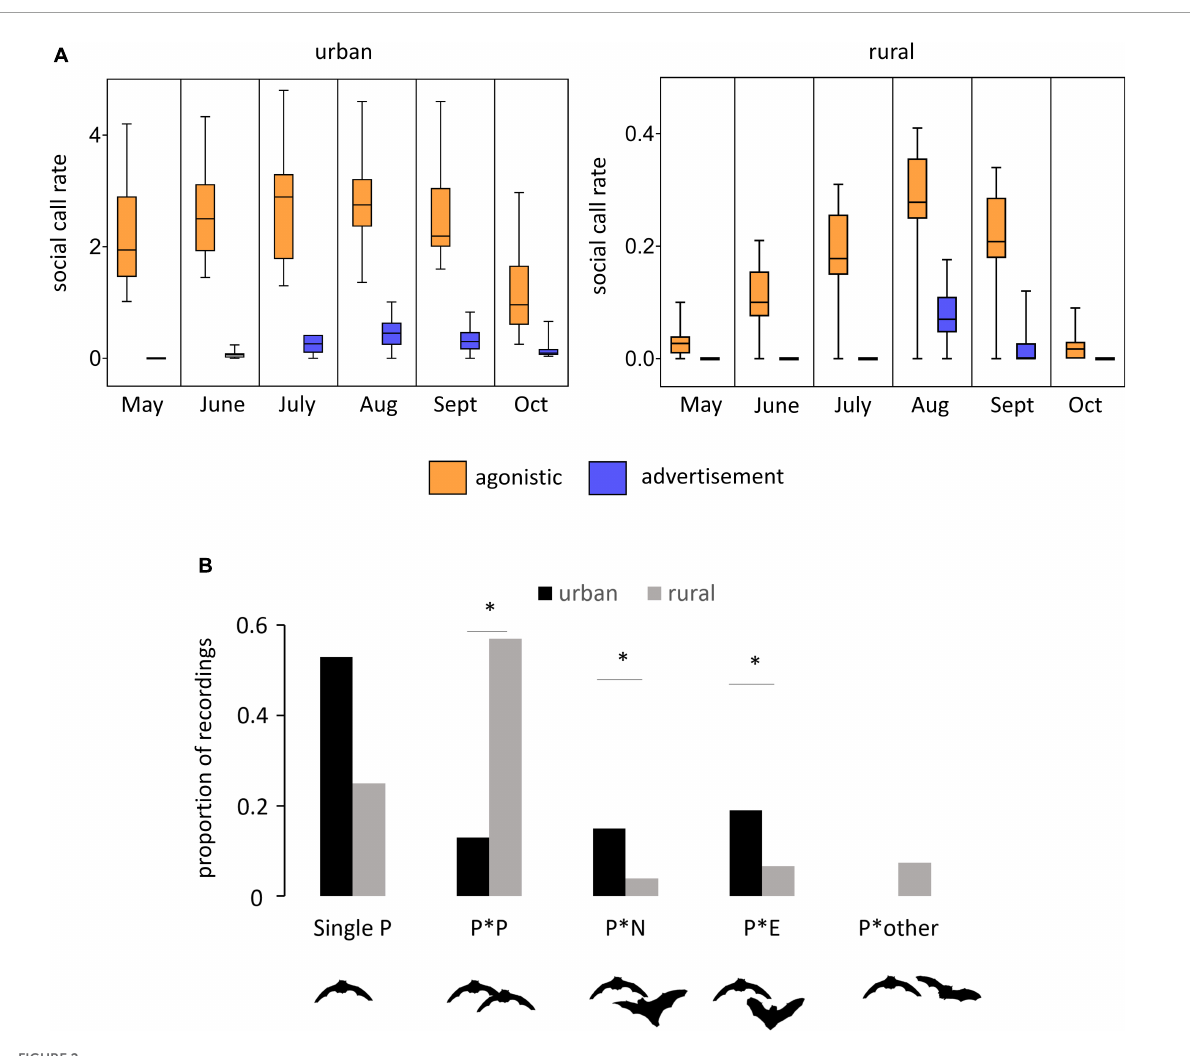
FIGURE2 Context of P . pipistrellus social call production in urban and rural green areas. (A) Boxplots of median social call rates indicating agonistic and advertisement behavior over the sample months. Social call rate, number of social calls per night. (B) Proportion of Type D foraging associated (agonistic) call sequences in relation to the presence of conspecifics (P × P) and heterospecifics (P × N, P × E, P × other; P, P . pipistrellus ; N, N . noctula ; E, E . serotinus ). * P <